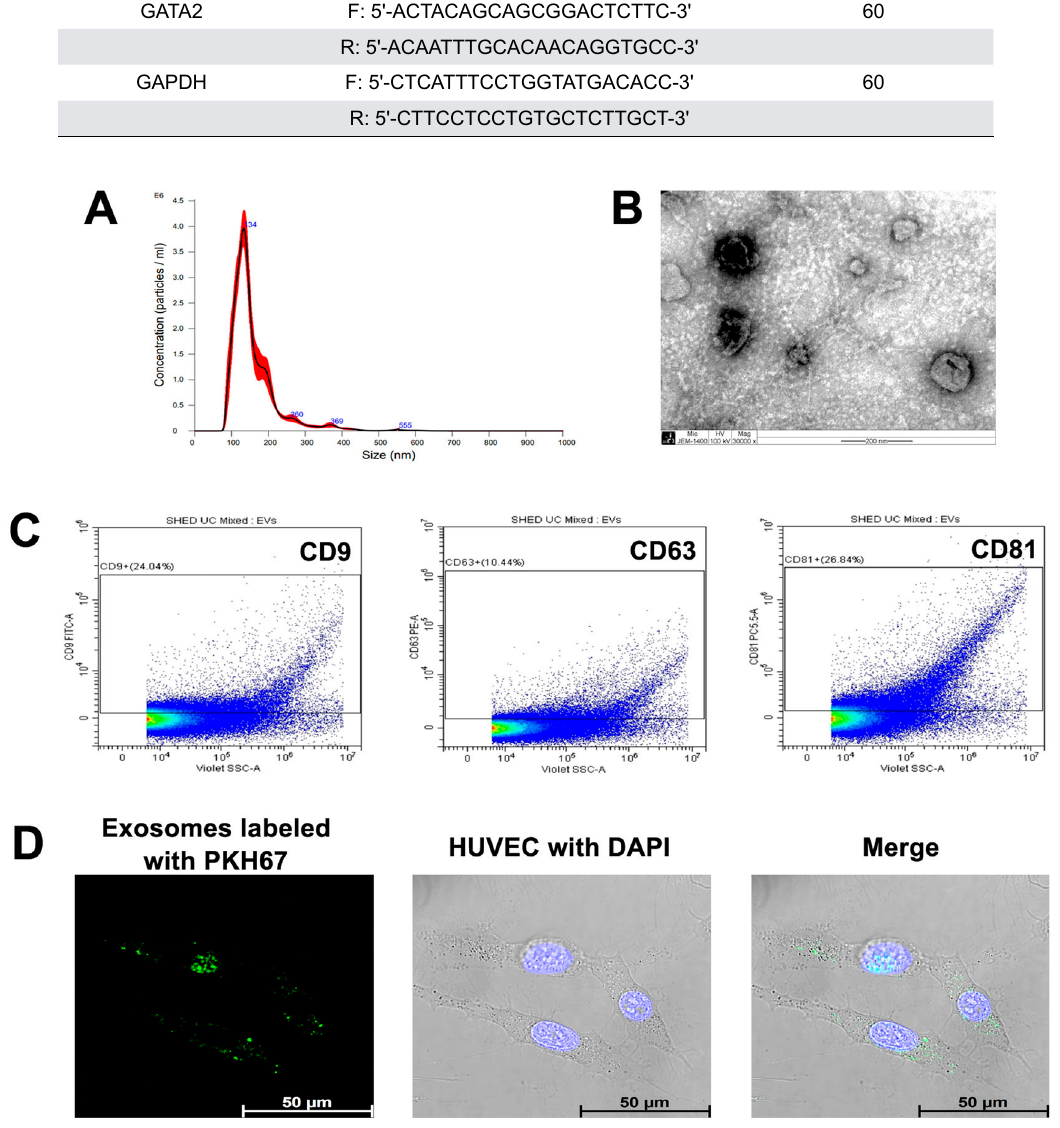
Figure 1- Characterization and internalization of SHED-exosomes. (A) Particle size distribution of SHED-exosomes assessed by nanoparticle tracking analysis (NTA). (B) The morphology of exosomes was observed using a transmission electron microscope (TEM). Scale bar = 200 nm. (C) surface markers of SHED-exosomes were analyzed by flow cytometry and were positive for exosome markers (CD9, CD63, and CD81). (D) Efficient uptake of PKH67-labeled exosomes (green) by HUVEC was detected in four hours. Nuclei were counterstained with DAPI (blue). Scale bars = 50